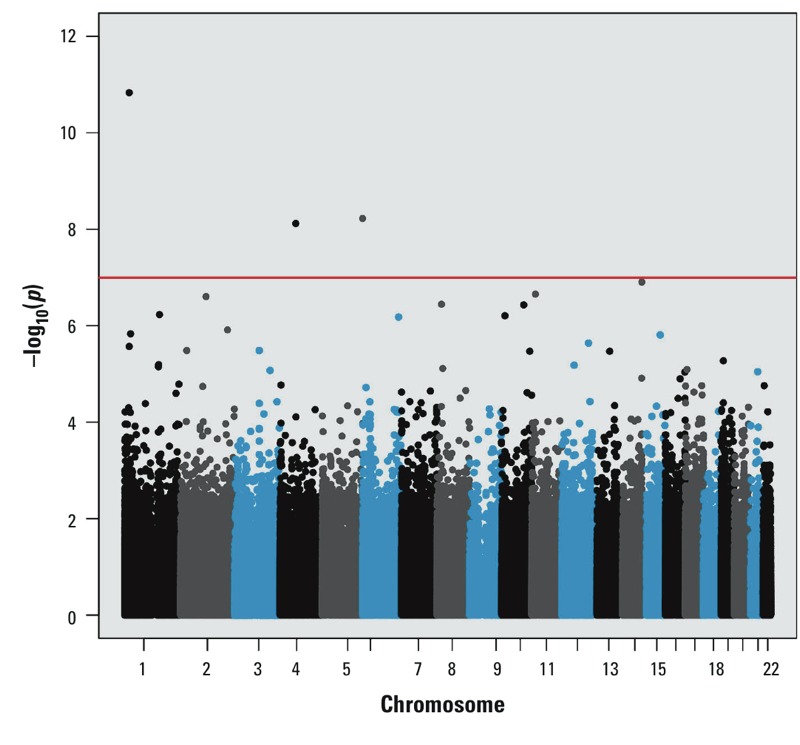
Manhattan plot for epigenome-wide association results for blood arsenic concentration. The horizontal red line corresponds to the significance threshold p = 1 × 10–7. Colors are used only to differentiate chromosomes.